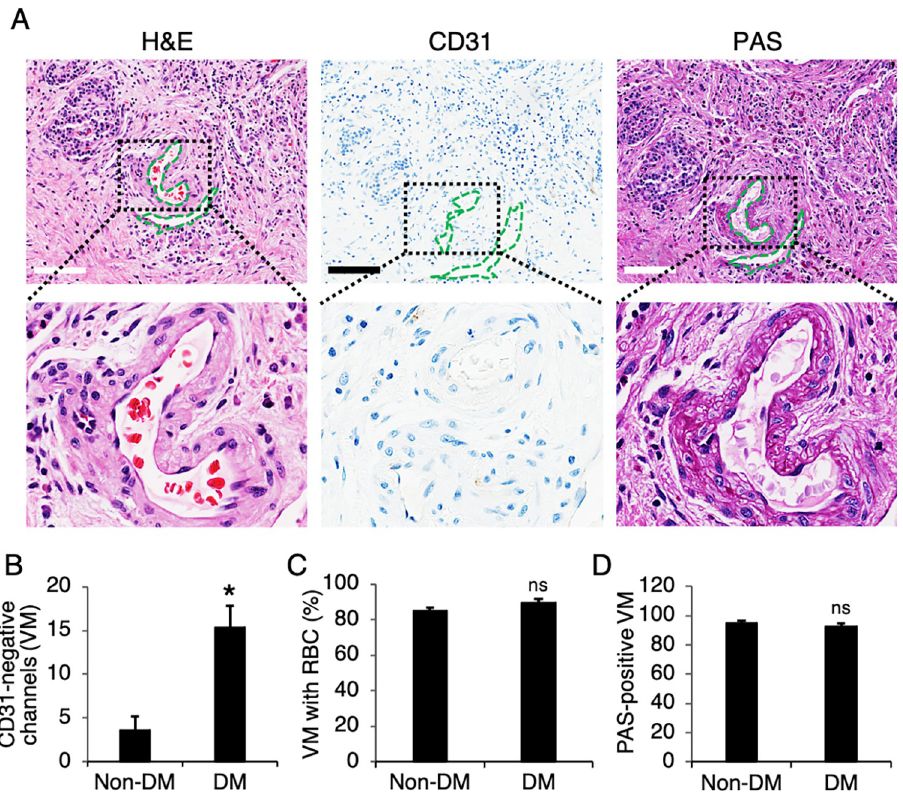
Fig 2. CD31-negative, PAS-negative channels were predominantly found in desmoplastic areas of PDAC. (A) PDAC tissues were stained with H&E, PAS and immunostained for CD31, and the insets demonstrated the vessel-like structures containing RBC. (B) CD31-negative channels or VM structures, (C) VM with RBC, and PAS-positive VM were quantitated and analyzed. Scale bars, 200 μ m. Data presented ± S.D. � P value < 0.01 (n =